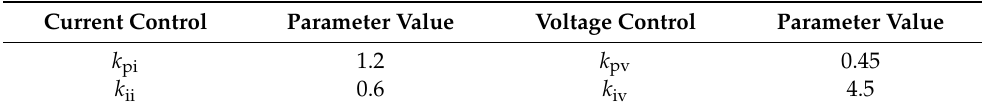
Table 3. The parameters of the current and voltage PI